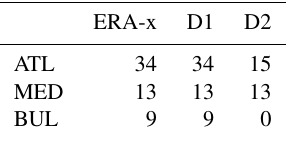
Table 6. Number of observations used for calculations of WNOE for each region and each forcing.